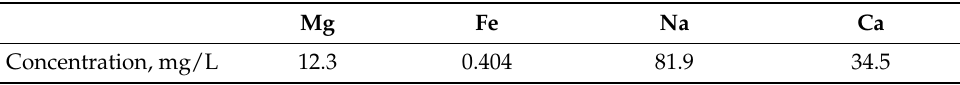
Table 1. The elements components of tap